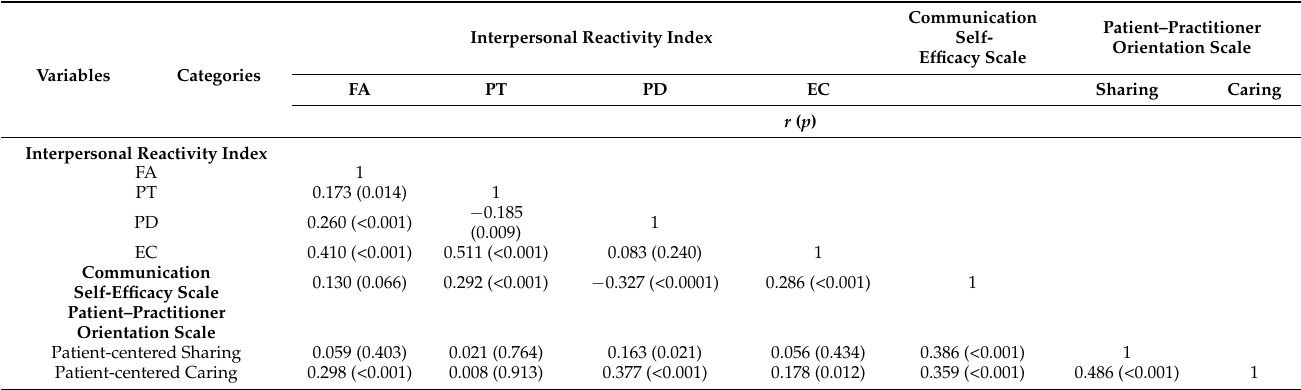
Table 3. Correlations between Interpersonal Reactivity Index, Communication Self-Efficacy, Patient–Practitioner Orientation Scale ( n =